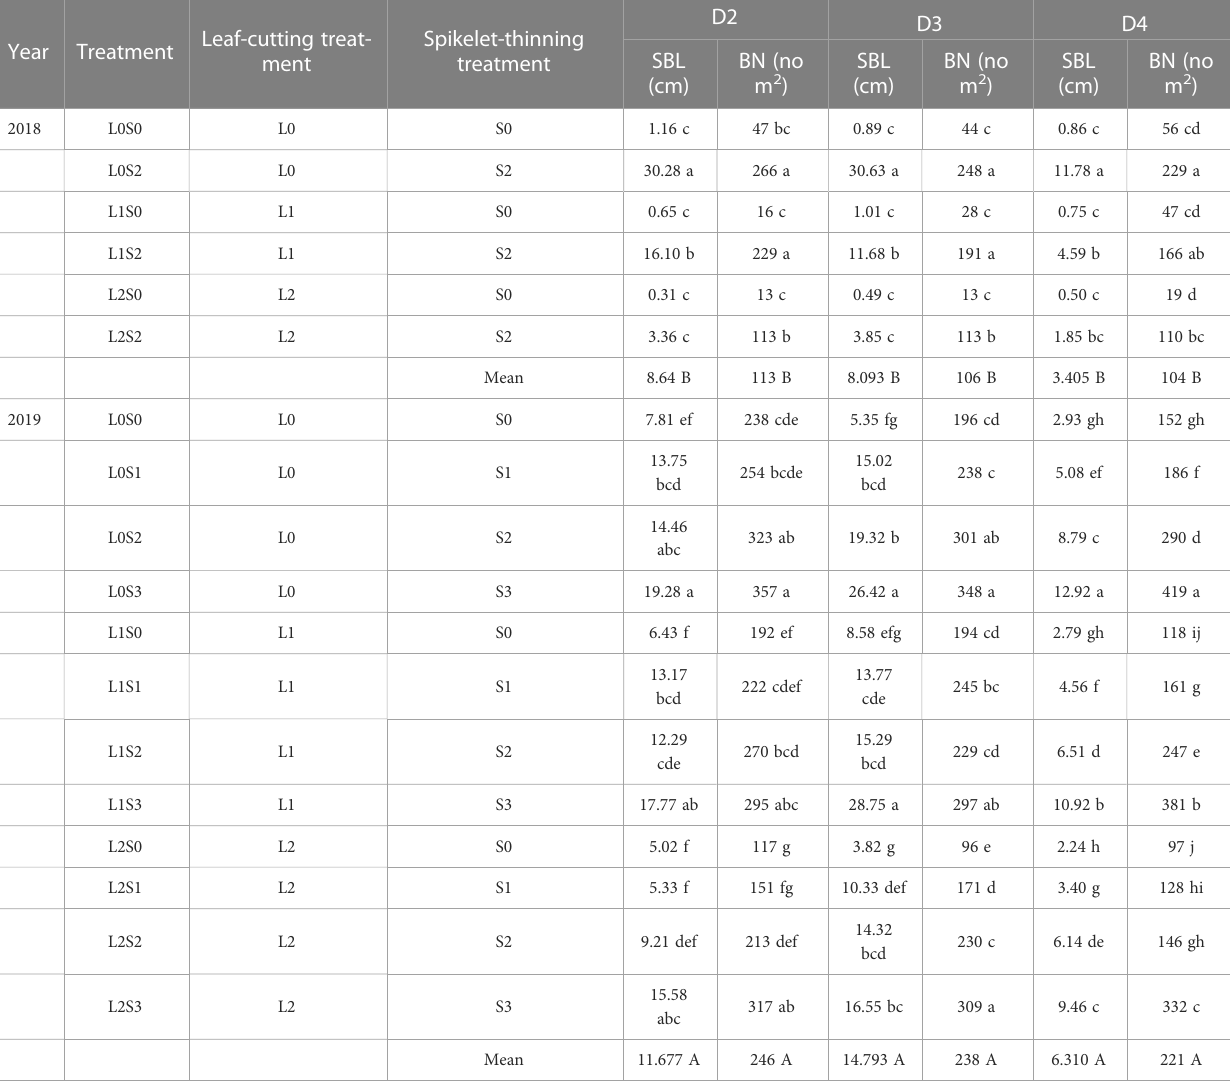
TABLE 1 Effects of leaf cutting and spikelet thinning on different nodes single bud length and number of bud per area at the maturity stage of the main crop.